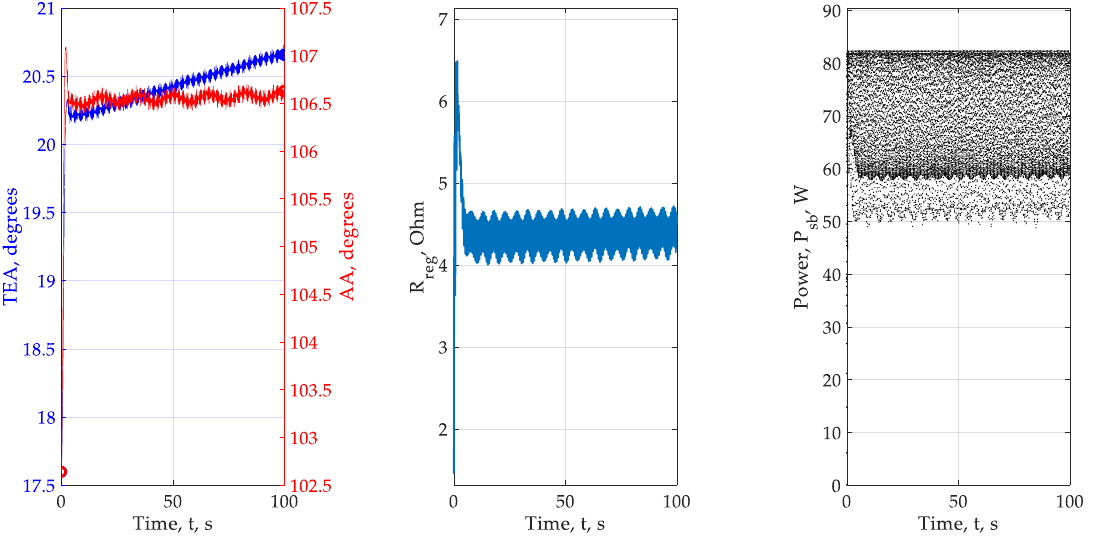
Figure 15. Experiment No.6 — PSM-150, 2019.